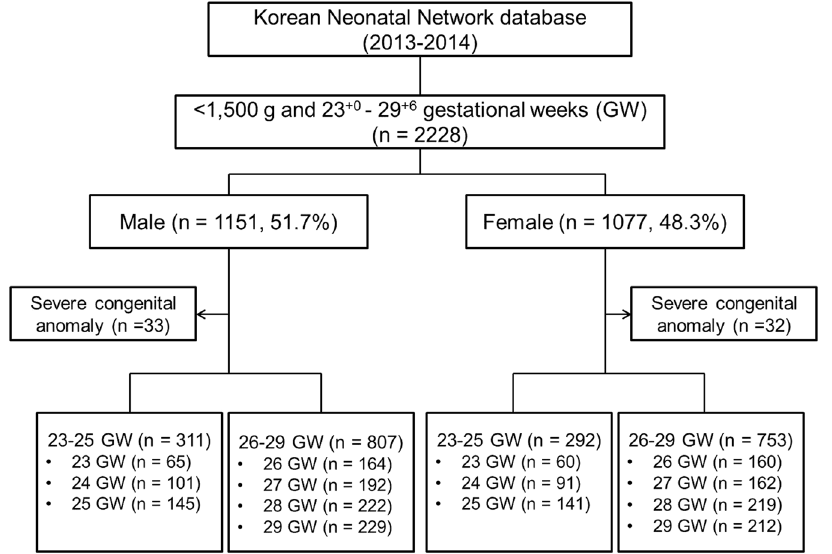
Figure 1. Study population from the Korean Neonatal Network